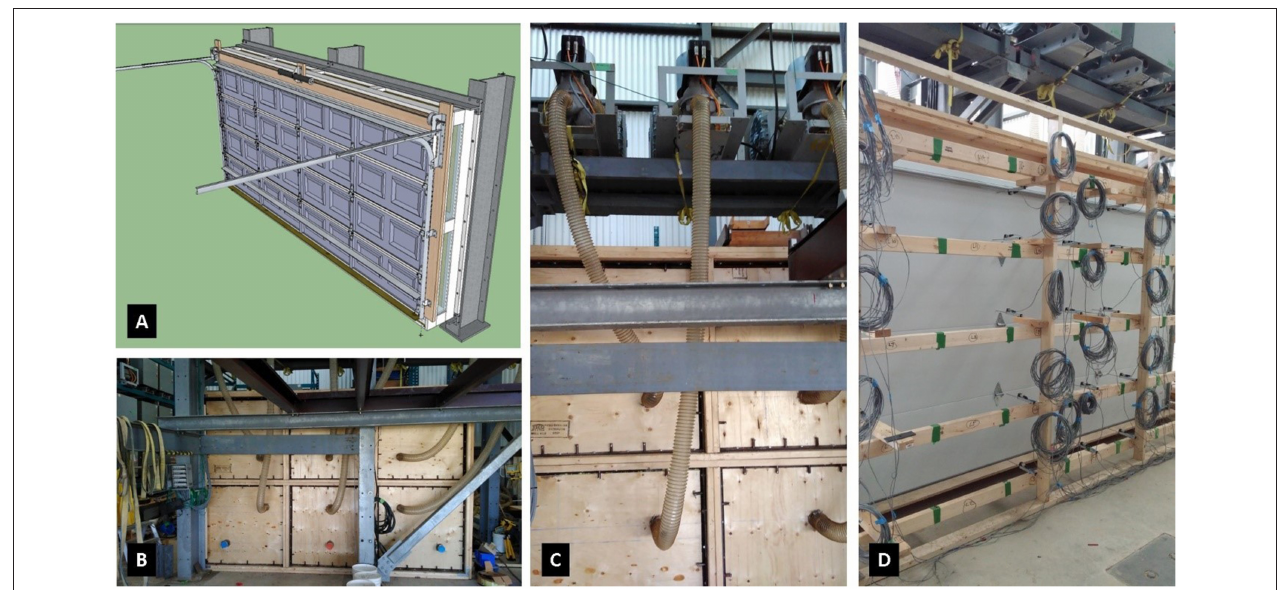
FIGURE 1 | (A) A conceptual image of the pressure chamber setup, and photographs of (B) its backside with (C) detailed connections to pressure load actuators (PLAs) and (D) the displacement transducer (LVDT) support frame.